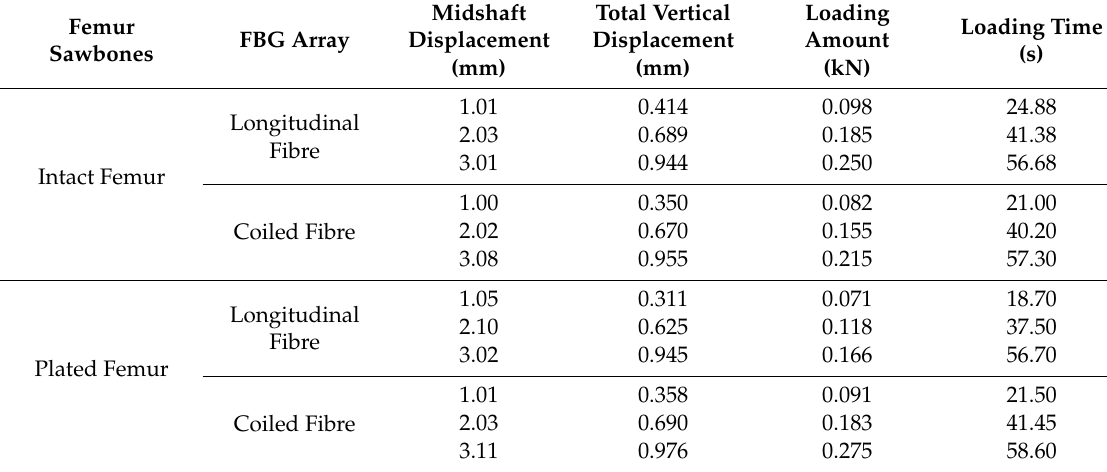
Table 2. Compression loading test parameters on femur sample during four different steps.